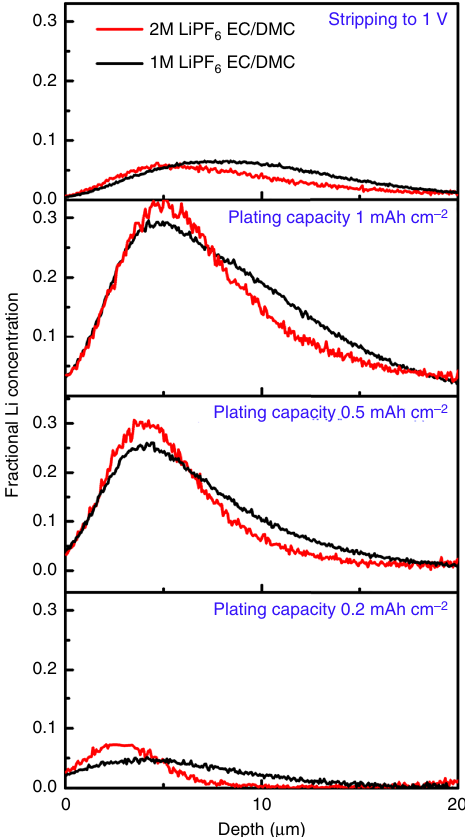
Fig. 4 Impact of the Li-salt concentration on the Li density distribution. Li density at different stages of the fi rst plating cycle and at the end of stripping at 1 mA cm − 2 comparing 1 molar and 2 molar LiPF 6 in EC/DMC. The depth is measured starting from the interface of the Cu current collector with the